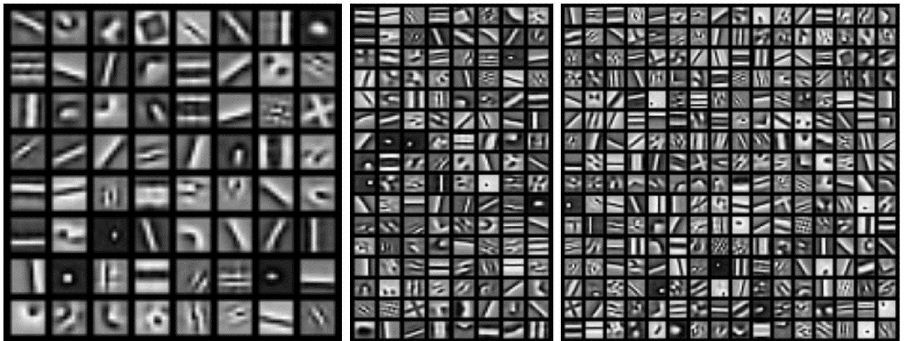
Fig 2. Complex-shaped convolutional sparse code dictionary. Learned feature dictionaries from the CSC algorithm applied to grayscale natural images with 64, 128, and 256 elements, each with a kernel size of 9px.